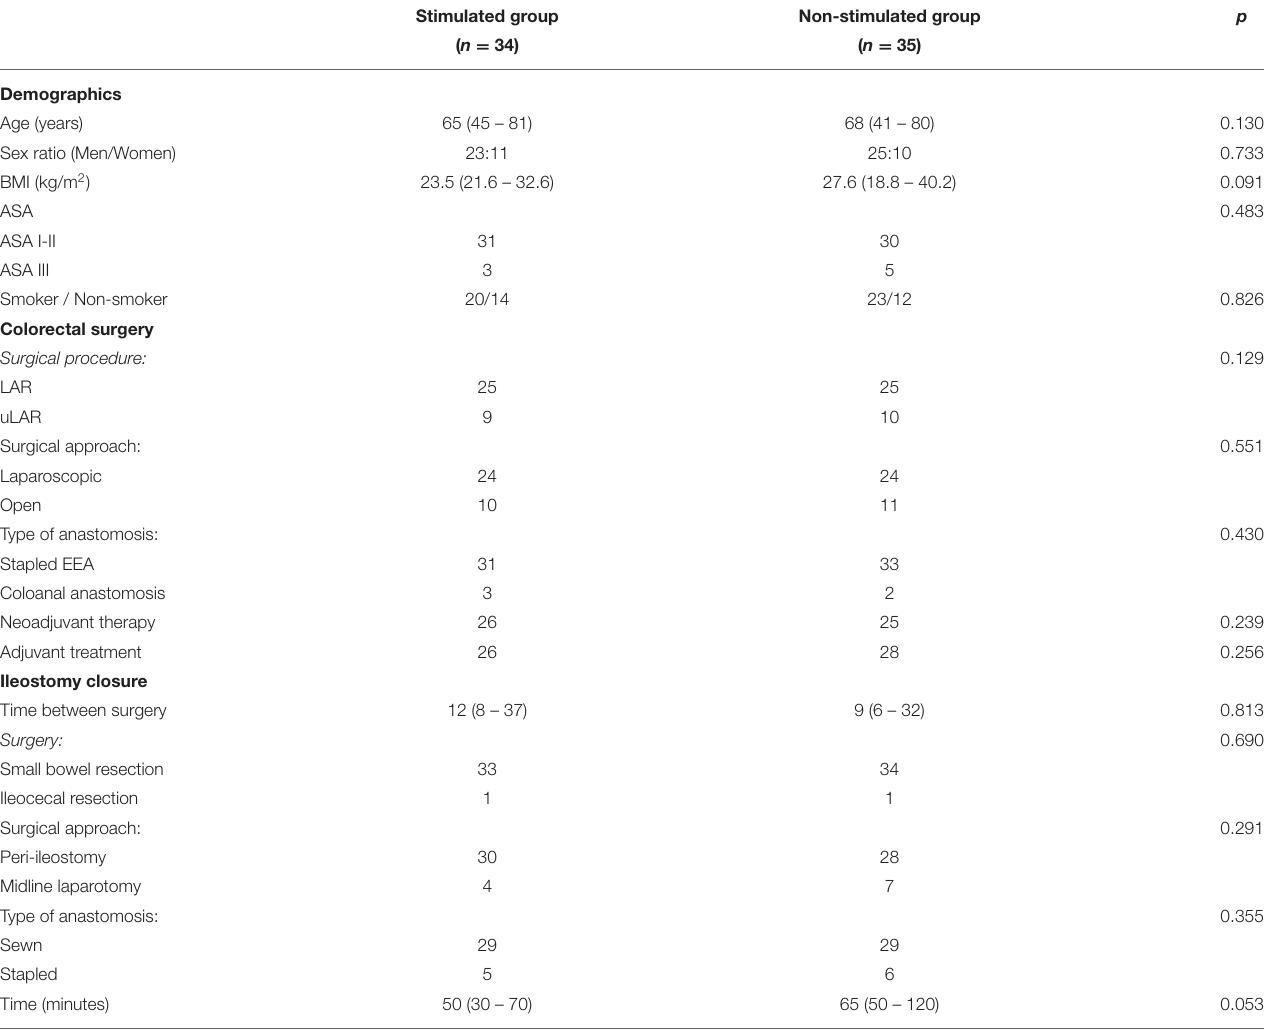
TABLE 1 | Demographics, clinics, and surgical characteristics. Stimulated group Non-stimulated